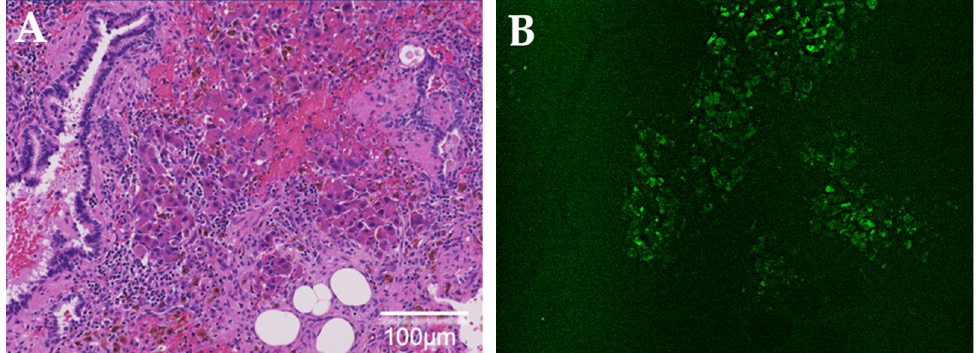
Figure 4. Histological examination via false-negative indocyanine green (ICG) fluorescence on intraoperative observation. ( A ) Lung metastatic cells of hepatoblastoma are identified in the hematoxylin and eosin-stained specimen. ( B ) ICG fluorescence is observed using a fluorescence microscope.